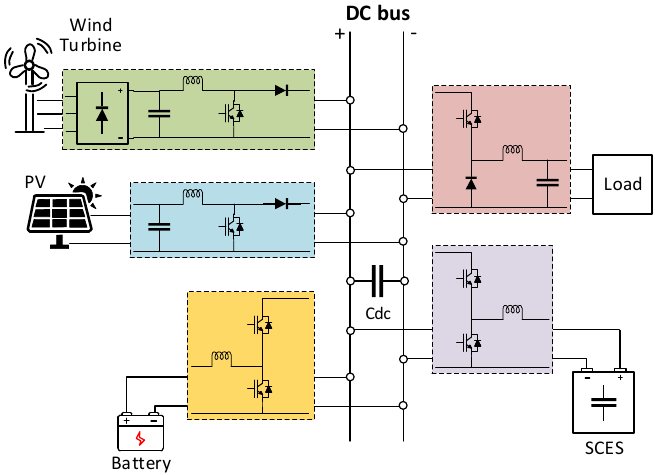
Figure 2. The schematic diagram of the overall system.